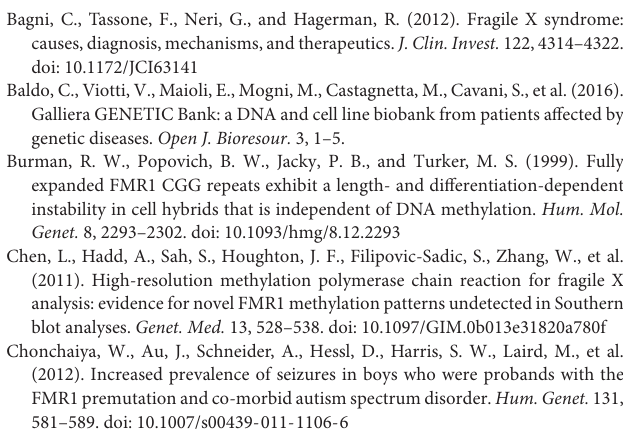
Figure 2 . ClB and MG directed the work and wrote